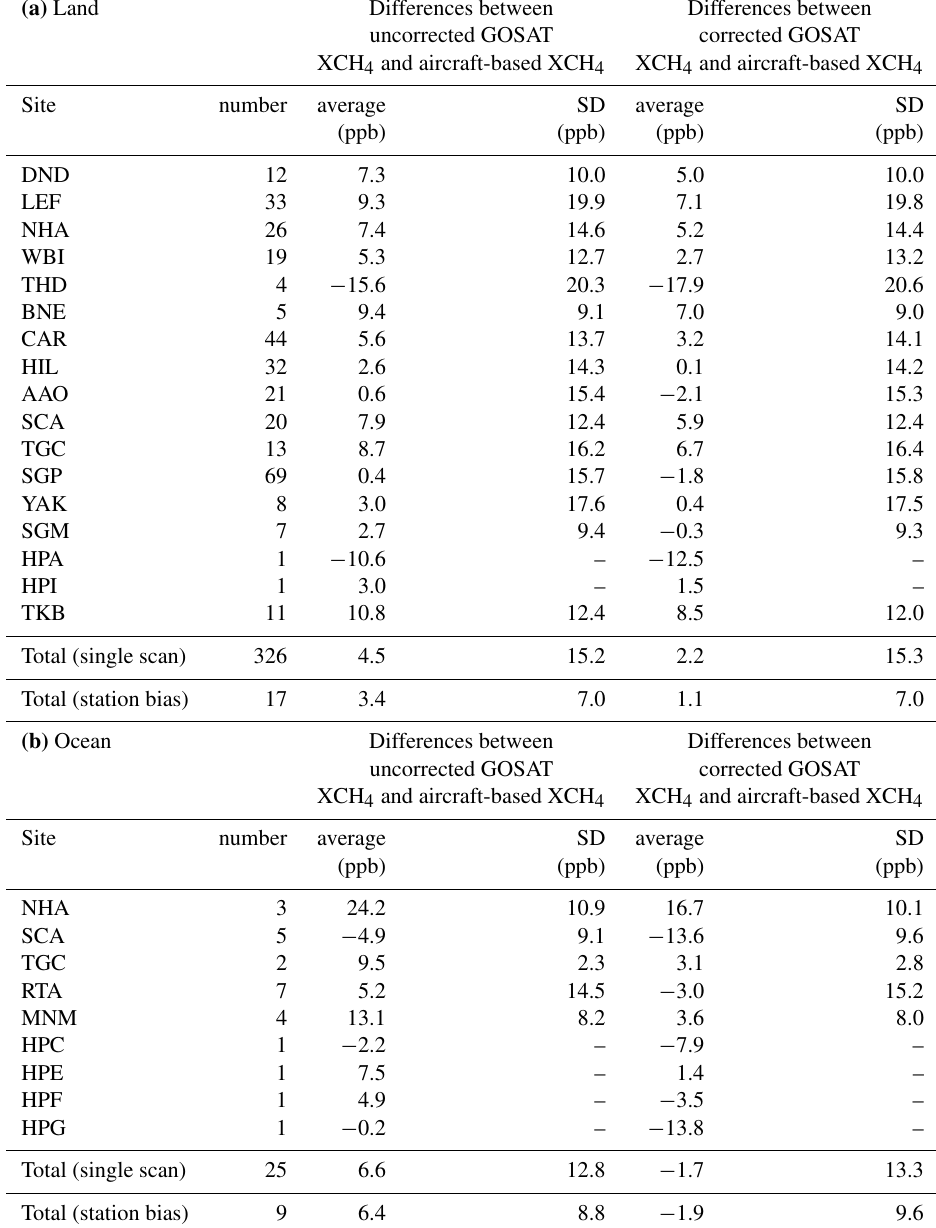
Table 7. The average and standard deviation of the differences between uncorrected/corrected GOSAT XCH 4 and aircraft-based XCH 4 at each aircraft observation site. The GOSAT data were retrieved over (a) land and (b) ocean regions within ± 5 ◦ latitude/longitude boxes centered at each site. The averages and standard deviations of the differences of the matched data at all aircraft observation sites (single scan) and those of the station biases are also shown in the second row from the bottom and the bottom row of the table,